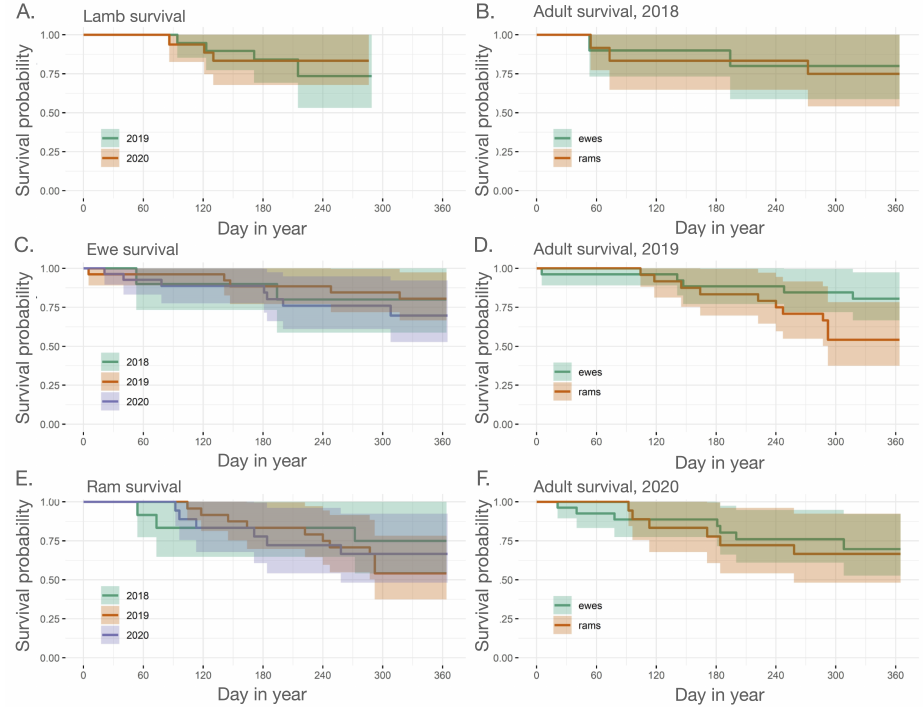
Figure A2. ( A – F ) Survival patterns by sex group and year within the Zion population over the duration of this